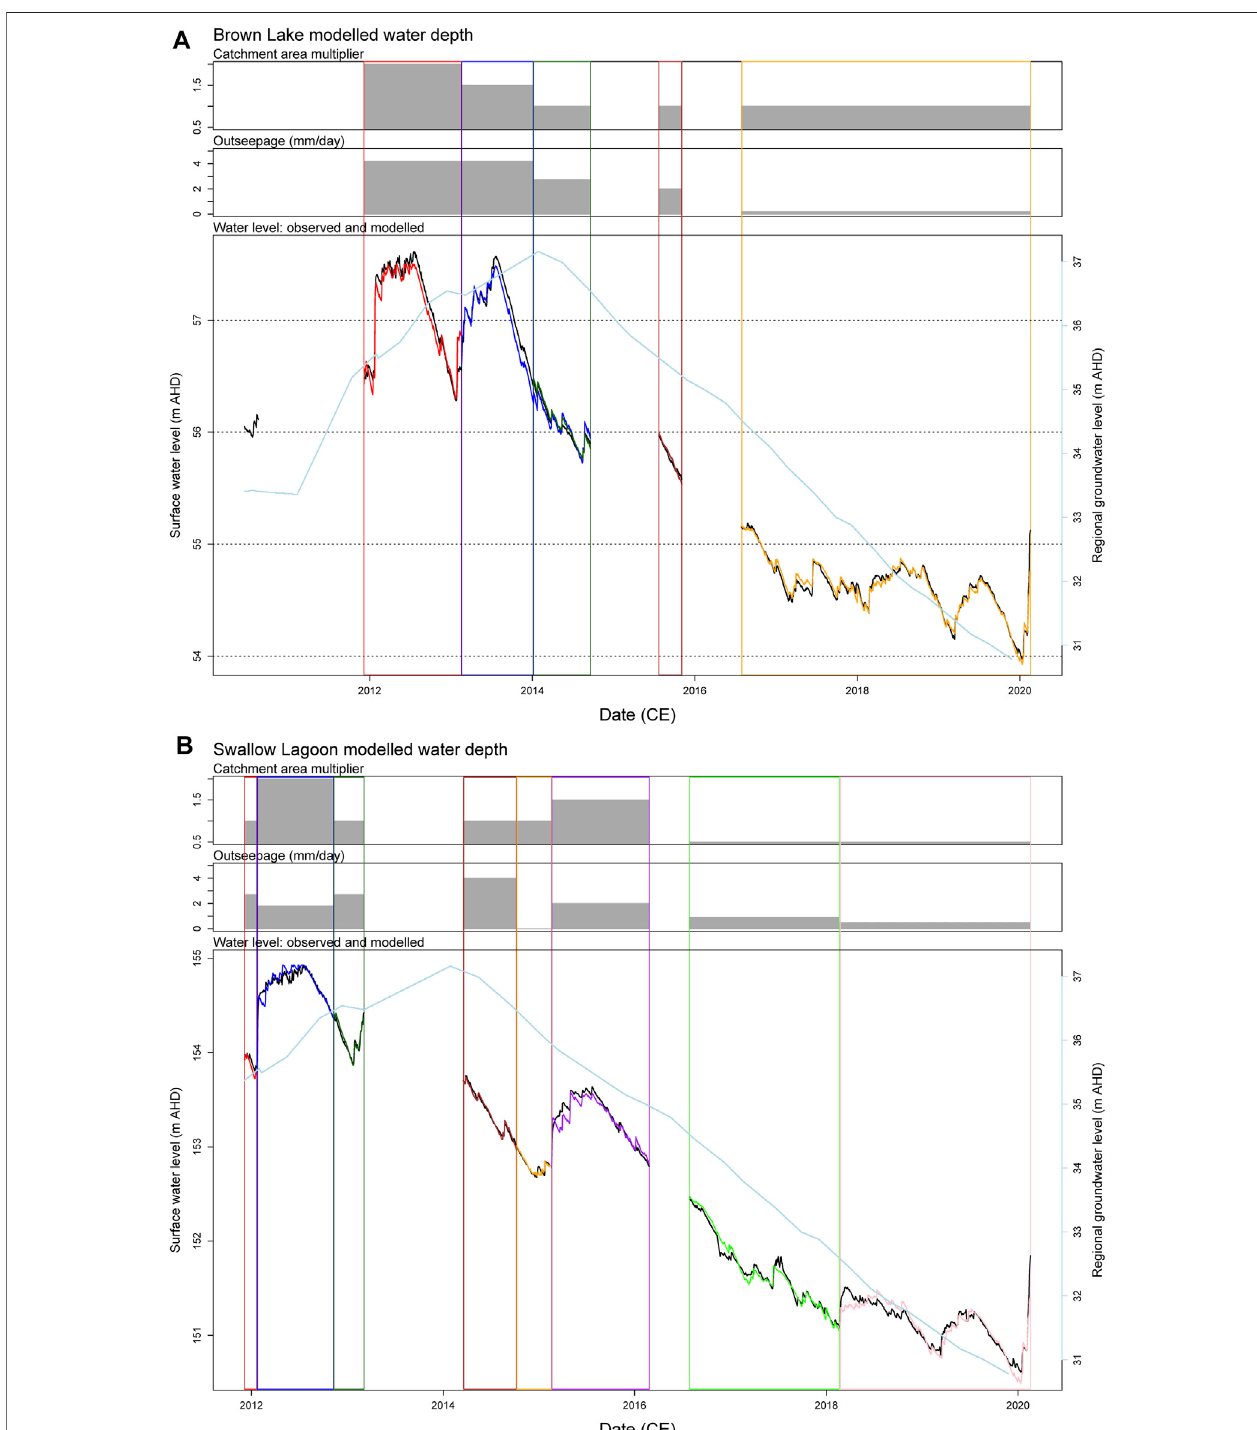
FIGURE 7 | Comparison of modelled (coloured lines) vs. observed (black lines) wetland water depth for (A) Brown Lake and (B) Swallow Lagoon. In both fi gures, thetwoupperpanelsillustratethecalibrationparametersrainfallcatchmentareamultiplier(wheretheinitialareaisthemaximumsurfaceareaofthelake)andoutseepage ratewhichwereiterativelyadjustedtobest fi tthemodelwithobservedchange.Thecolouredboxesindicatethedifferentcalibrationperiods.Theelevationoftheregional water table is shown in light blue.